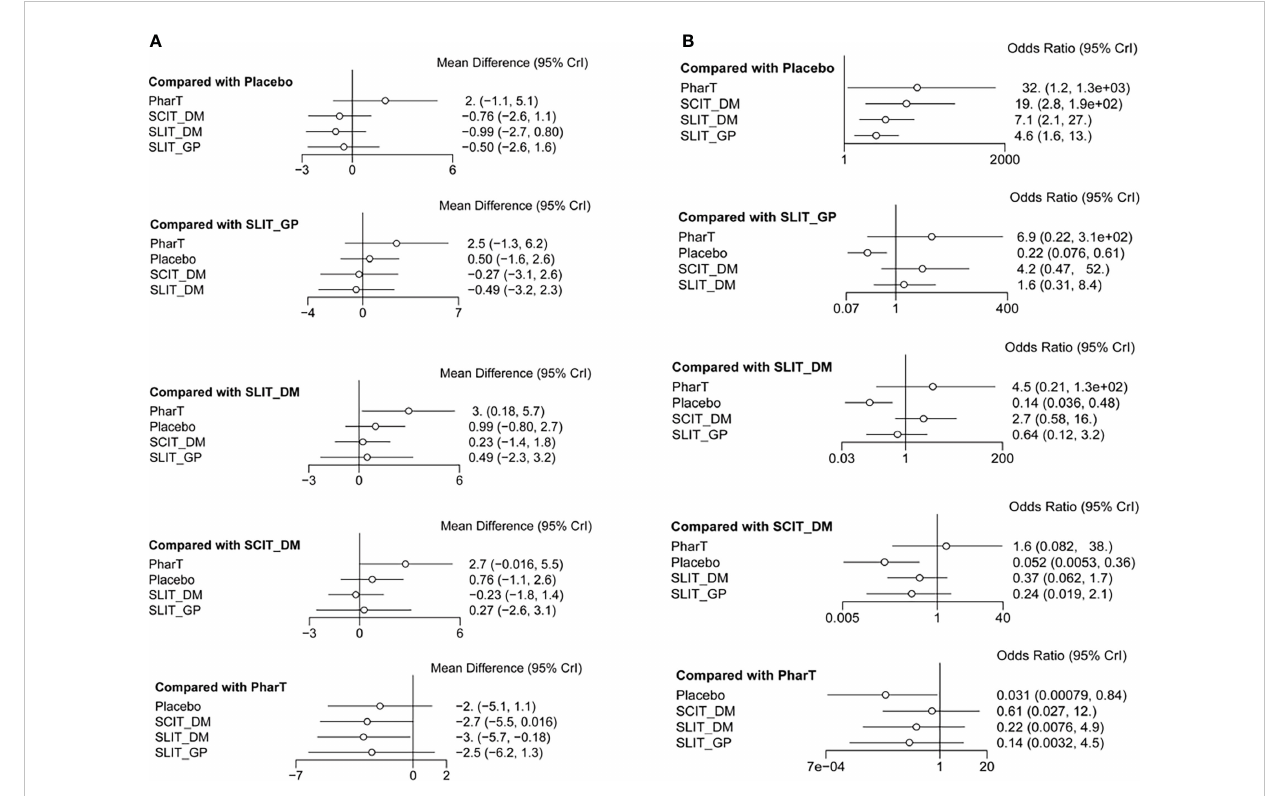
FIGURE 5 Forest plot for symptom scores (A) . Forest plot for adverse reactions (B) .